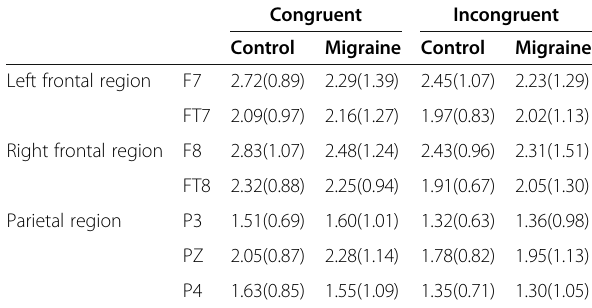
Table 4 SP mean amplitudes during the congruent and incongruent conditions at three